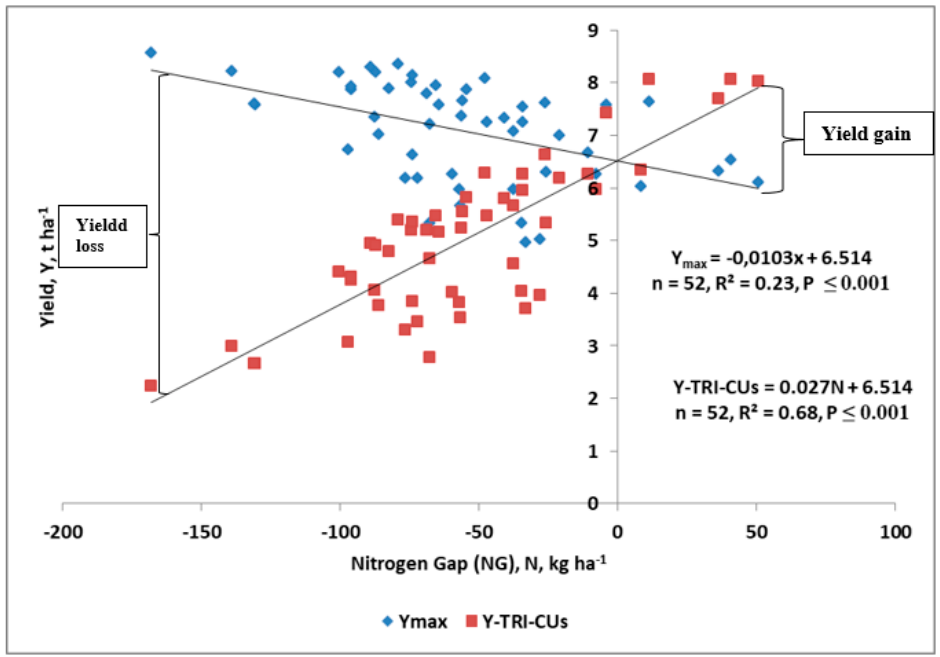
Figure 6. Trends in real and maximum yields in response to nitrogen gap—WTR. Y-TRI-CUs, Y max —real and maximum attainable yields of WTR expressed in cereals units.